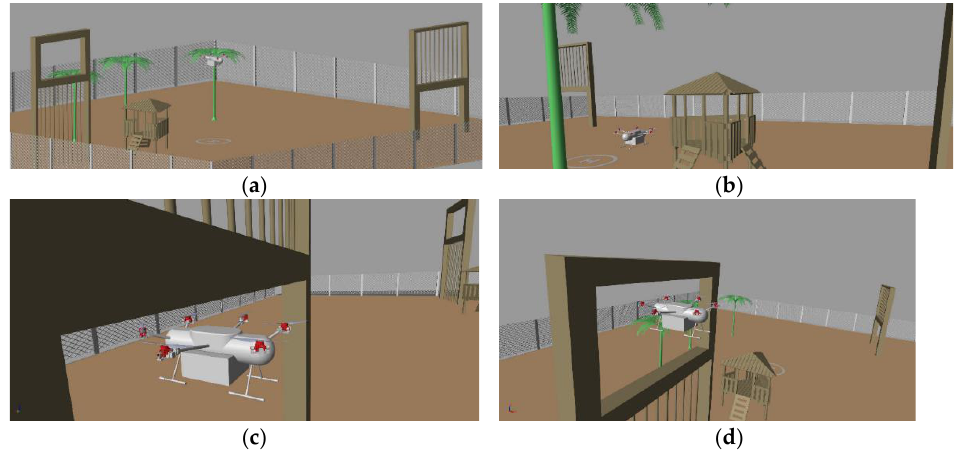
Figure 18. Trajectory following simulation result with actuator-1 failed ( a ) Take-off ( b ) Landing ( c ) Passing through obstacle 1 ( d ) Passing through obstacle 2.